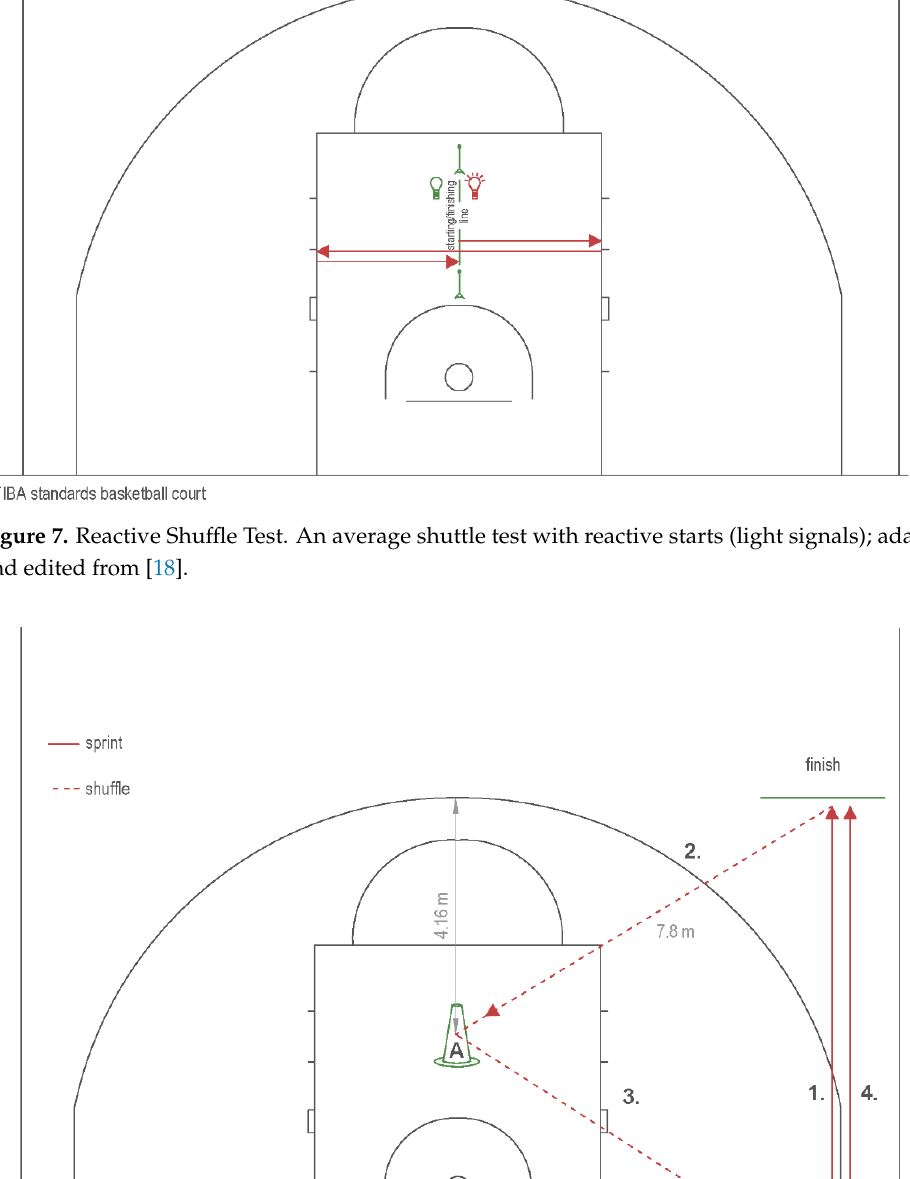
Figure 8. The trajectory of the Run-Shuffle-Run Test, consisting of sprinting and running; adapted and edited from [18] .